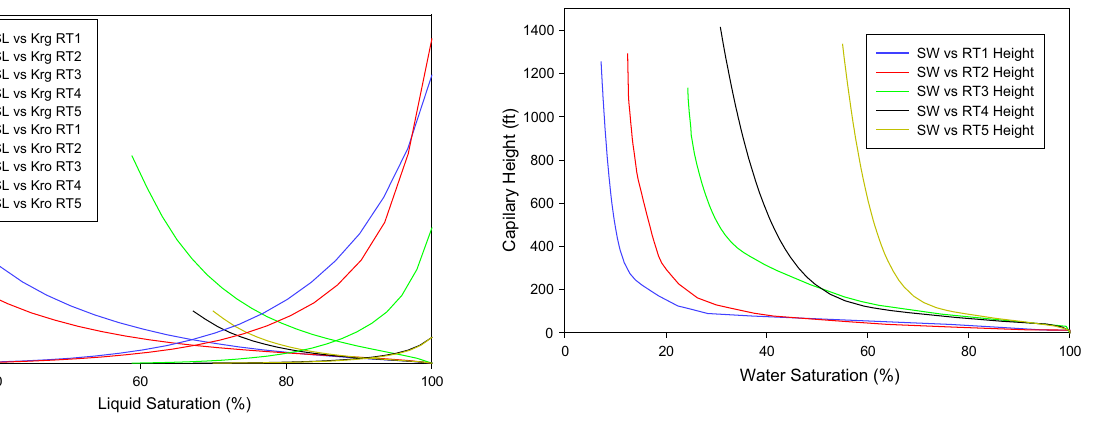
Fig. 11 Average capillary height curves of water–oil drainage process for different classes of rocks. This figure is derived from Fig. 6 by Eq. (7)